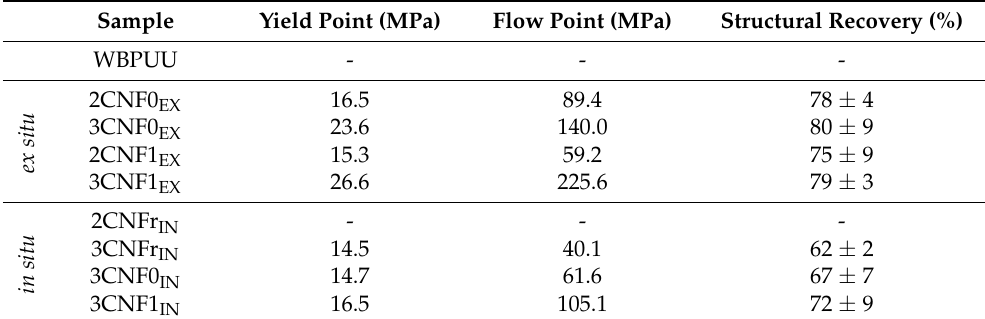
Figure 5. Structure recovery tests of WBPUU/CNF inks. 0